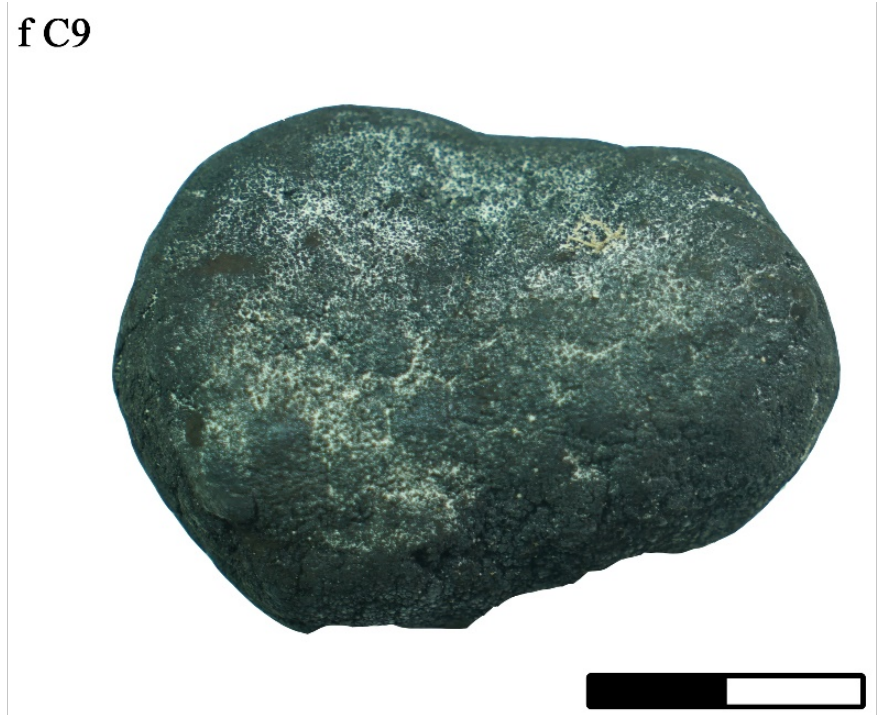
Figure 2. ( a ) Internal texture of C9R-6, which is composed of obvious changes of layers that are are mostly composed of dense ferromanganese oxide layers with low porosity and loose ferromanganese oxide layers with high porosity filled with siliceous debris, but the layers are not nearly parallel; ( b ) botryoidal shapes whose diameter is 1–2 cm on the surface; ( c ) internal texture of C9R-7, which is composed of obvious changes of nearly parallel layers that are mostly composed of dense ferromanganese oxide layers with low porosity and loose ferromanganese oxide layers with high porosity filled with siliceous debris; ( d ) botryoidal shapes whose diameter is 1–2 cm on the surface; ( e ) internal texture of C9, which is composed of a substrate as the nucleus inside, and outer layers composed of ferromanganese oxides; ( f ) smooth oolitic surface structure where siliceous debris can be seen in the cracks.